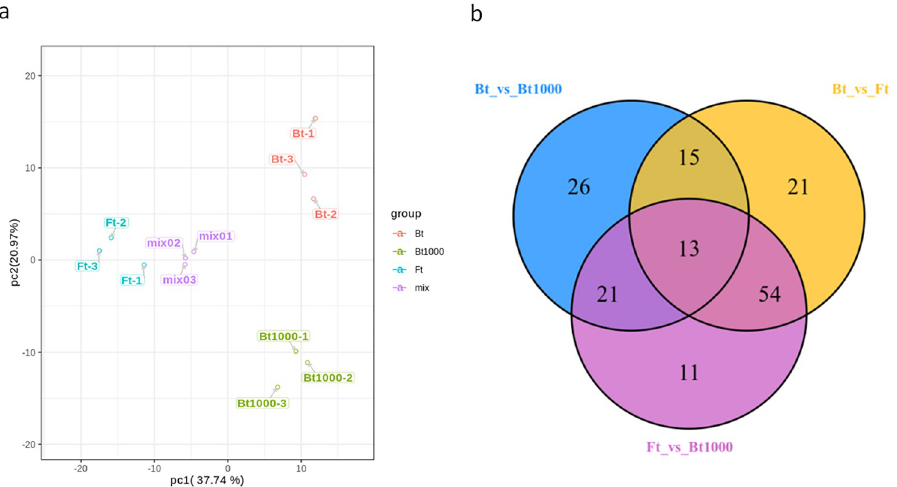
Fig 3. Multivariate analysis of metabolic profiling. (a): principal components analysis (PCA) of metabolites. (b): Venn diagram representing the numbers of differentially accumulated metabolites (DAMs). Ft indicates the flowering type, Bt indicates closed bud type and Bt1000 indicates MeJA-treated closed bud type